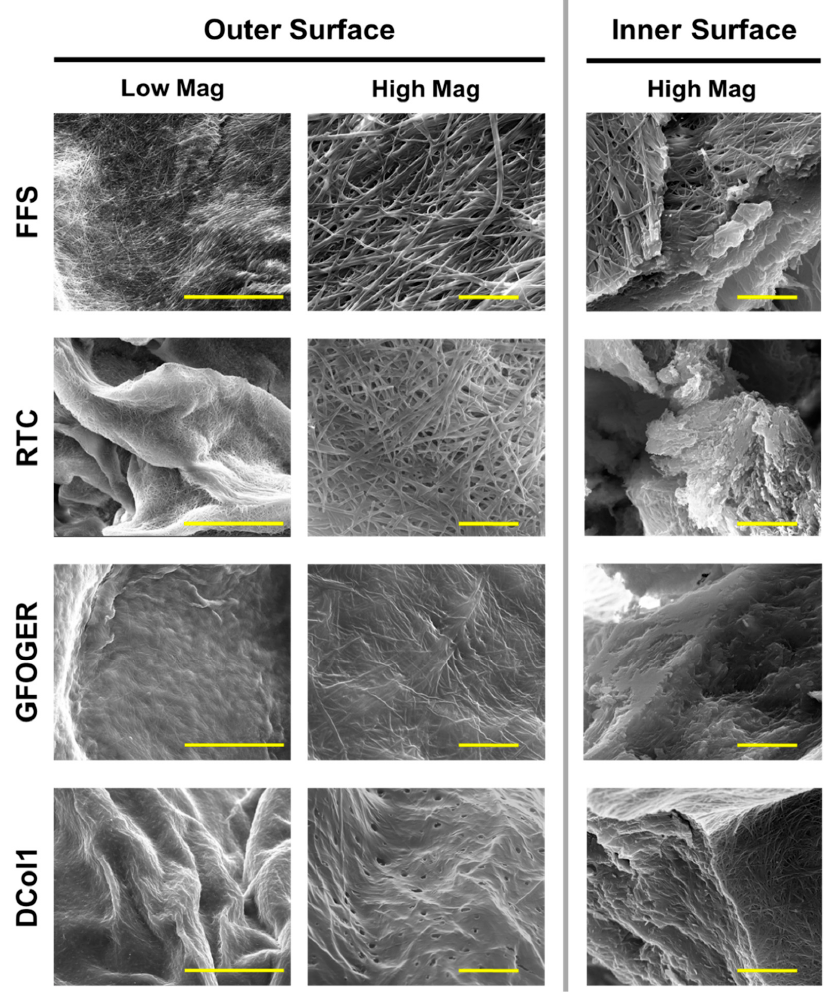
Figure 4. Scanning electron microscopy images showing the outer ( left ) surface morphology of Fmoc-FF/S and the collagen-modified hydrogels and a cross section showing the inner ( right ) surface morphology at lower and higher magnification, respectively. Low magnification scale bar is 50 µm; high magnification scale bar is 5 µm.